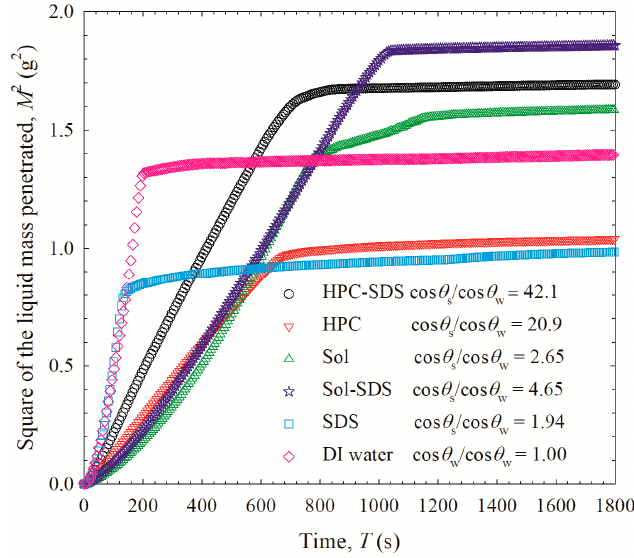
Figure 7. Temporal evolution of the liquid mass M penetrating a packed bed of as-received GF particles. Liquids: GF-saturated deionized (DI) water and various GF-saturated aqueous solutions of 15% HPC / Sol with 0.125% SDS and without SDS, and 0.125% SDS alone. The legend shows the wetting e ff ectiveness factor cos θ s / cos θ w calculated for each liquid. As deionized water was taken as the reference, cos θ s / cos θ w equals 1, by definition, for water.